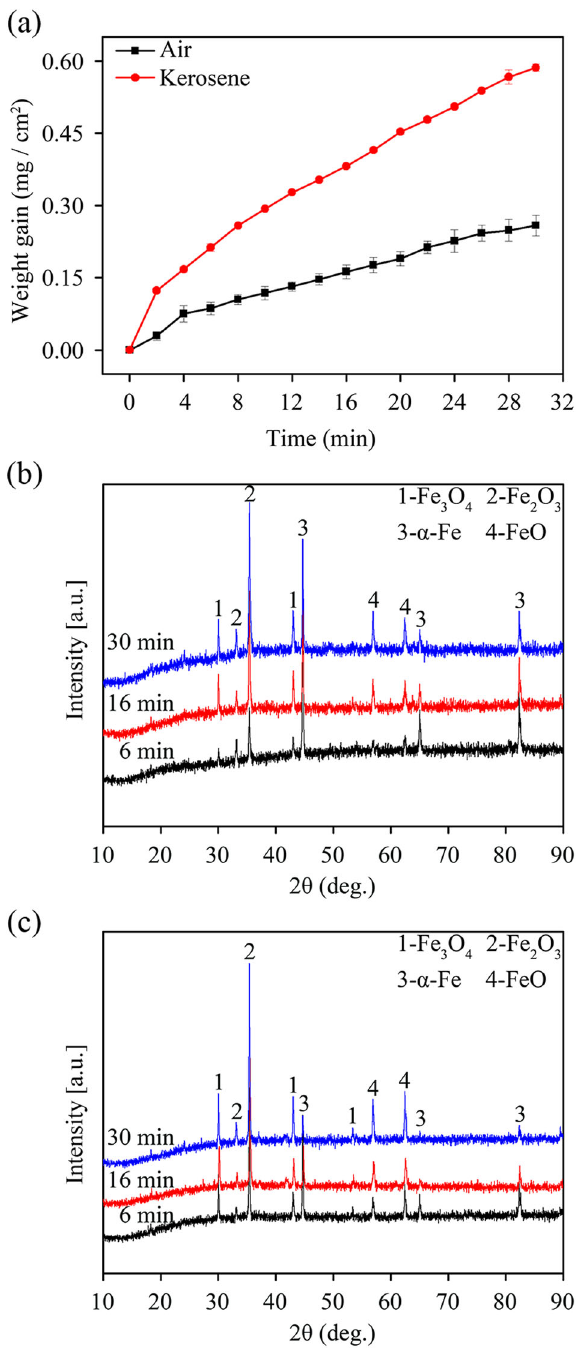
Fig. 4 The high-temperature oxidation at 700 °C. a Oxidation kinetics of 37Mn5 steels after oxidation for 30 min. b XRD patterns of 37Mn5 steels after oxidation in air. c XRD patterns of 37Mn5 steels after oxidation in kerosene.